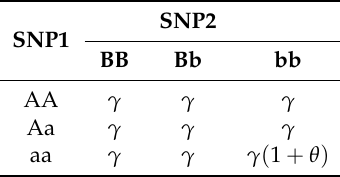
Table 2. Odds table of the recessive-recessive